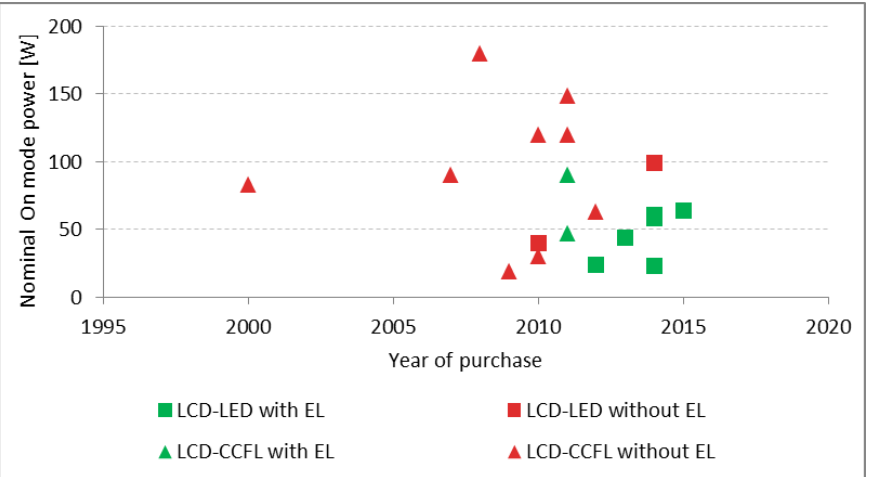
Figure 4. Relationship between nominal power and screen size for different LCD technologies (EL: energy label).